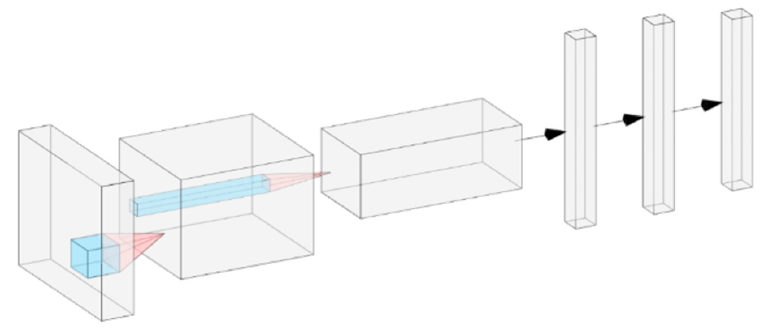
Figure 2. Schematic diagram of convolution neural networks.